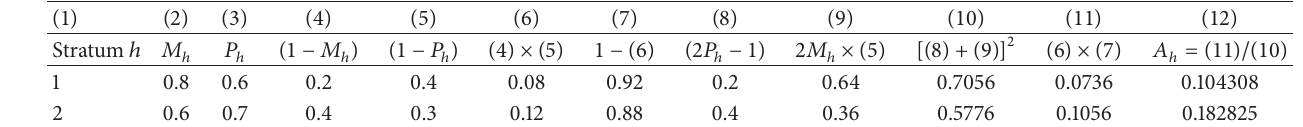
Table 2: Computation for 𝐴 ℎ .